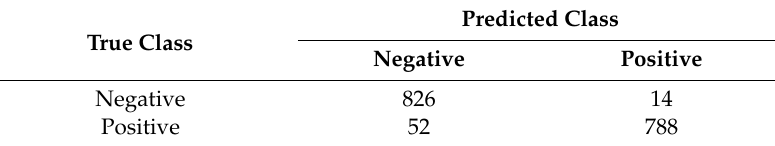
Table 7. Deep FC1 features and LR classifier.